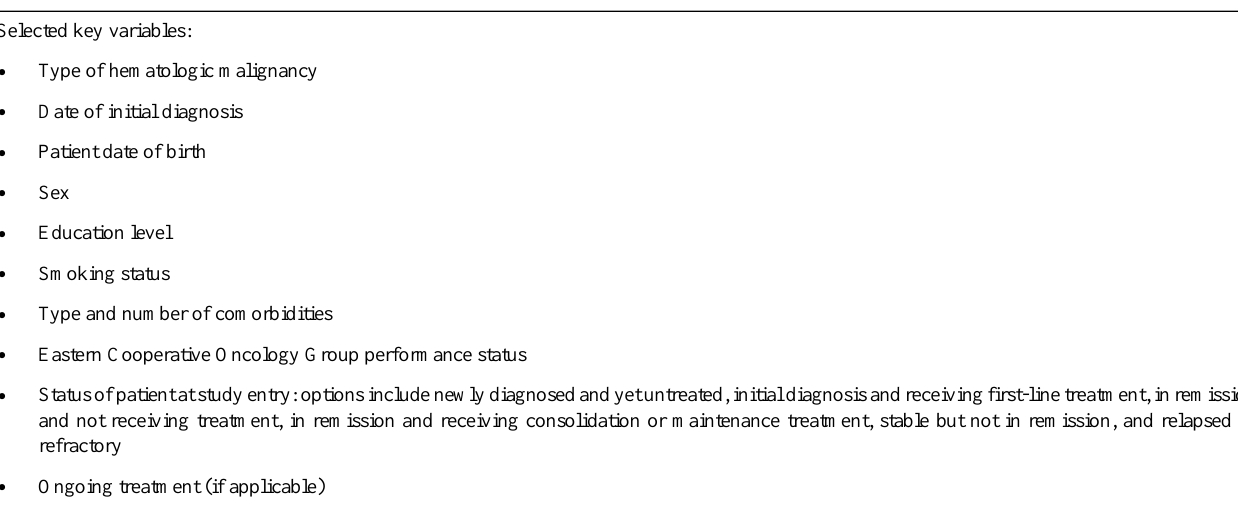
To confirm eligibility criteriaAt the time of registration in the plat- formOnceRegistration checklist To comprehensively understand patients’ characteristics and disease status at study To monitor treatment, disease progression, and status of patient (including survival status) at To collect information on COVID-19 severity, symptoms, and To better understand the implications of